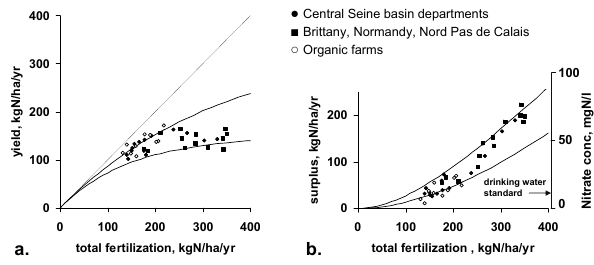
(a) Relationship between crop yield and total fer- tilisation (both expressed in kgNha − 1 yr − 1 ) of agricultural land of the different French d´epartements mainly involved in the Paris food supply. The following mathematical func- tion has been fitted to give the upper and lower bounds of the data points: yield=Ymax · (1 − exp( − Fert/Ymax)), with fertilisation minus crop yield) plotted against fertilisation. The cor- responding theoretical sub-root water concentration, calculated as- suming a mean runoff depth of 300mmyr − 1 , is also indicated (right scale). The data available for a number of organic farms in the Seine watershed (unpublished results) are also shown for compari- son (open